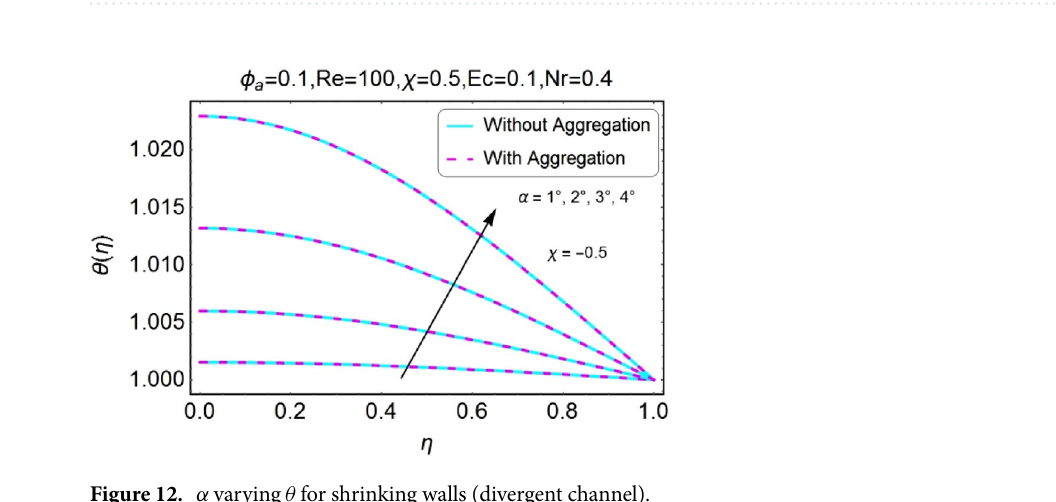
Figure 11. α varying θ for stretching walls (convergent channel).